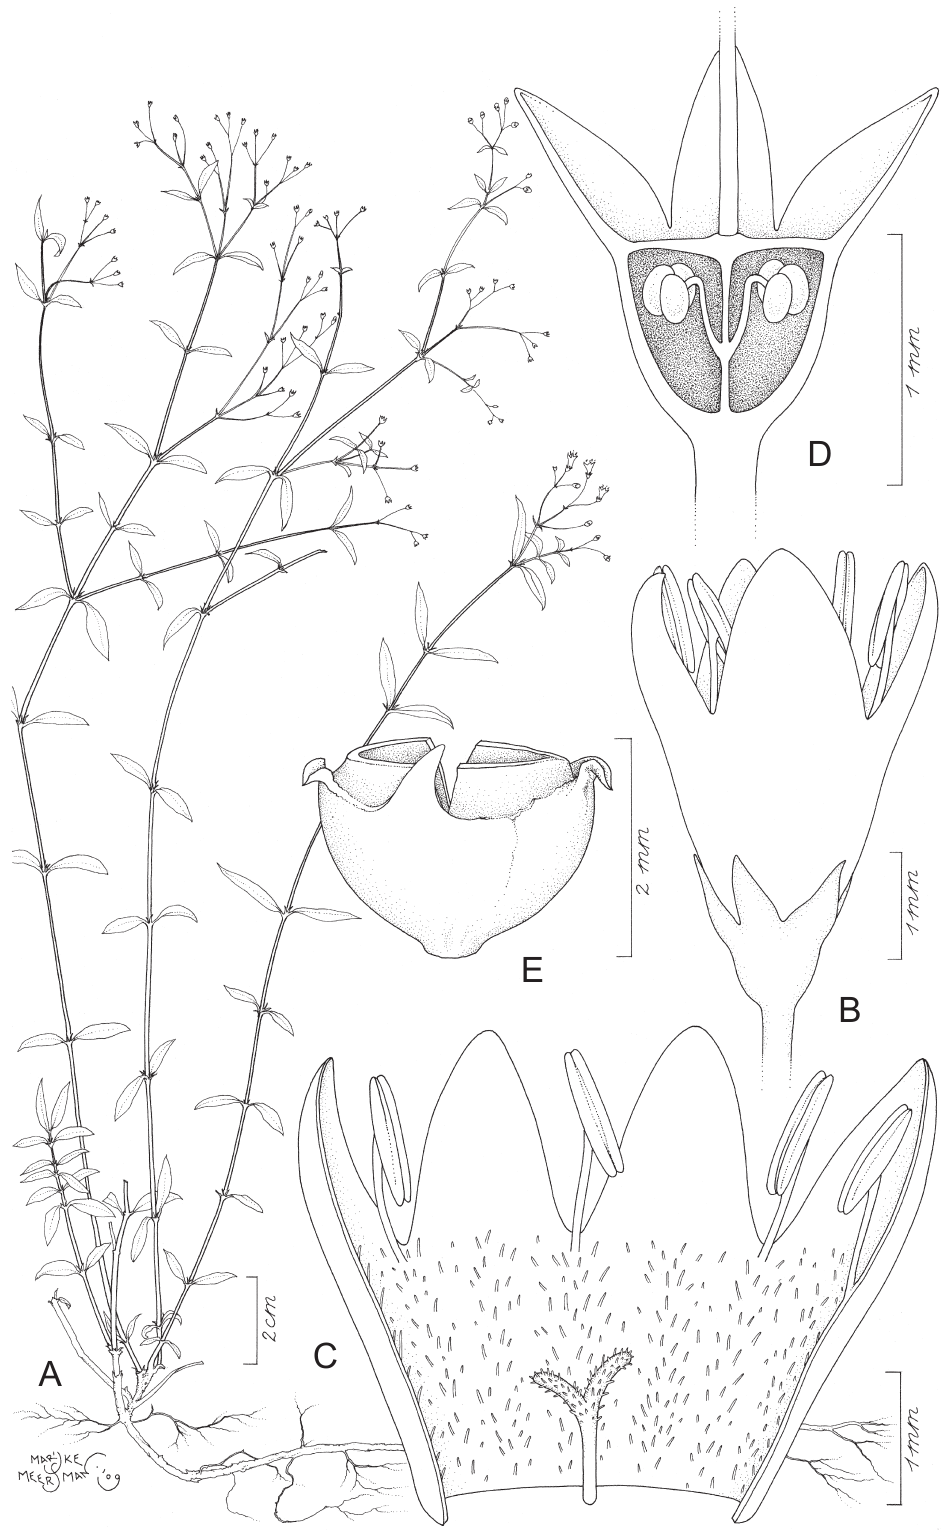
Fig. 6. Astiella confusa Groeninckx sp. nov. A . Habit. B . Brevistylous flower. C . Open brevistylous flower. D . Ovary dissected to show placentation. E . Capsule. Drawn by Marijke Meersman. All from Humbert 20713 (BR)